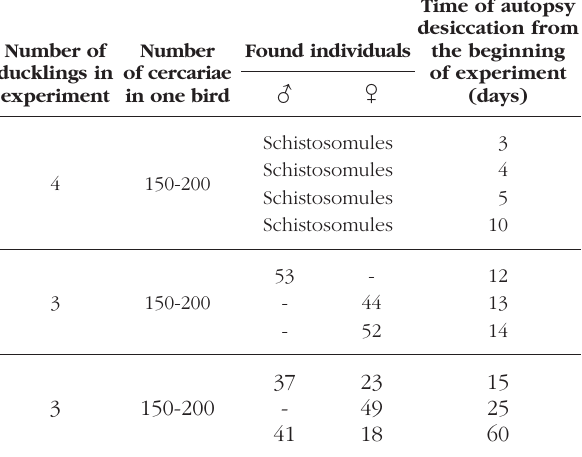
Table V. – Time of development of D. loossi in the definitive host